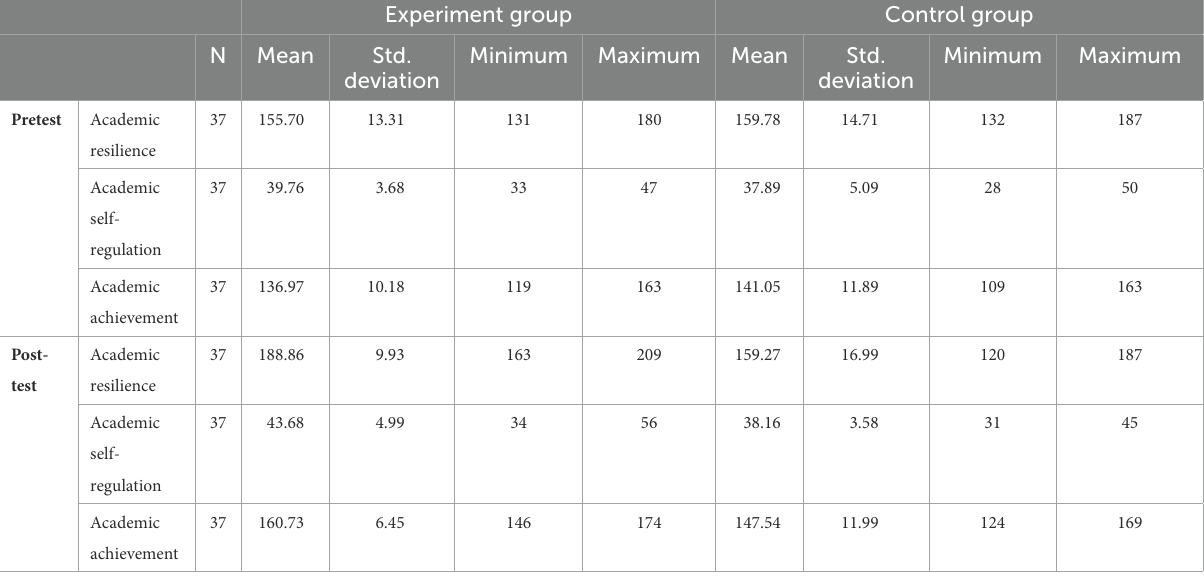
TABLE 1 Central indicators and dispersion of pre-test and post-test in control and experimental